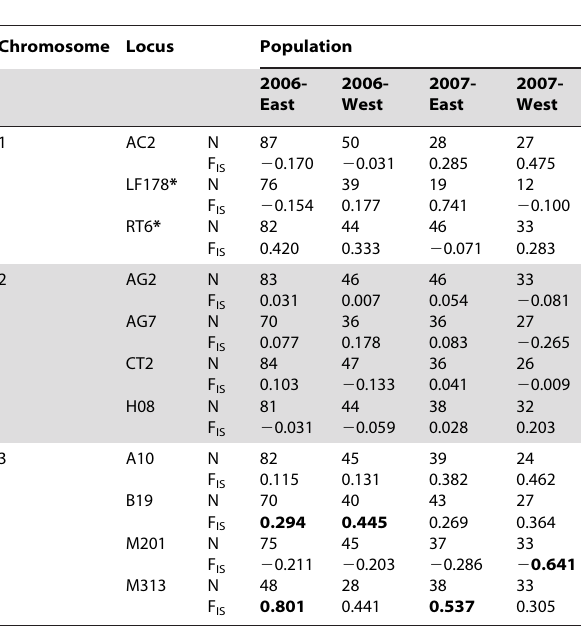
Table 2. Summary of variation at 9 microsatellite and 2 SNP loci by